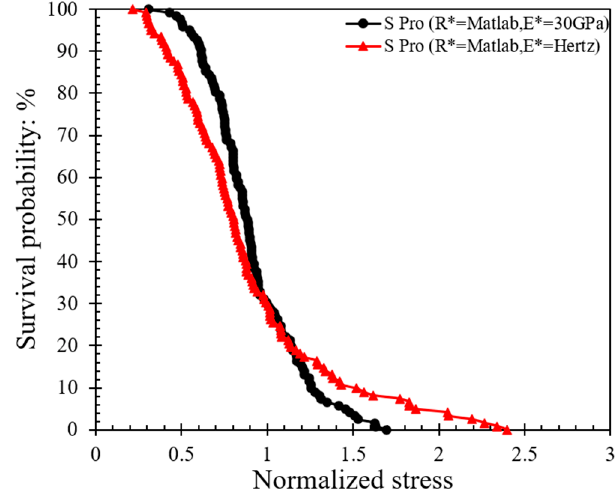
Figure 10. Effect of equivalent modulus on the survival probability at 0.01 mm/min speed.